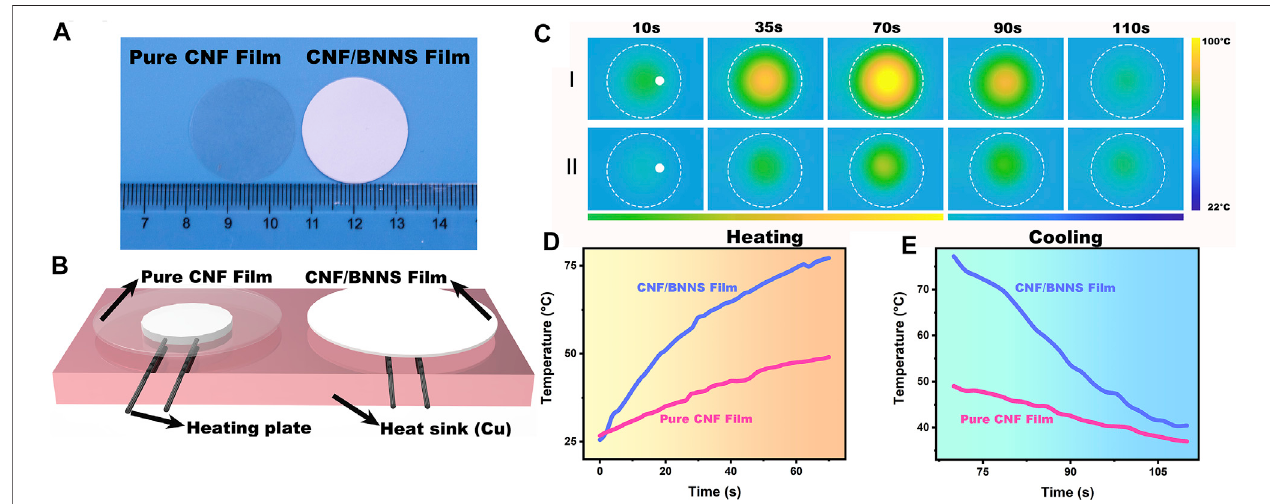
FIGURE6|(A) PhotographsofpureCNF fi lmand90 wt%BNNScontentcomposite fi lm, (B) TestmodelforIRimages, (C) IRimagesofCNF/BNNScomposite fi lm with 90 wt% BNNS content at a suspension concentration of 0.1 wt% and pure CNF fi lms heated and cooled with a ceramic heating plate heat source, (D) The heating curve and (E) the cooling curve as functions of